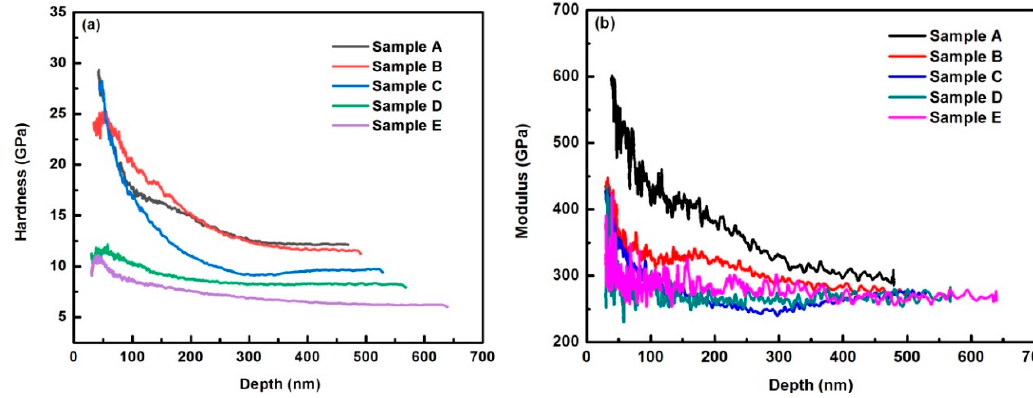
Figure 5. ( a ) The hardness-depth curve of different printed samples; ( b ) The elastic modulus-depth curve of different printed samples.